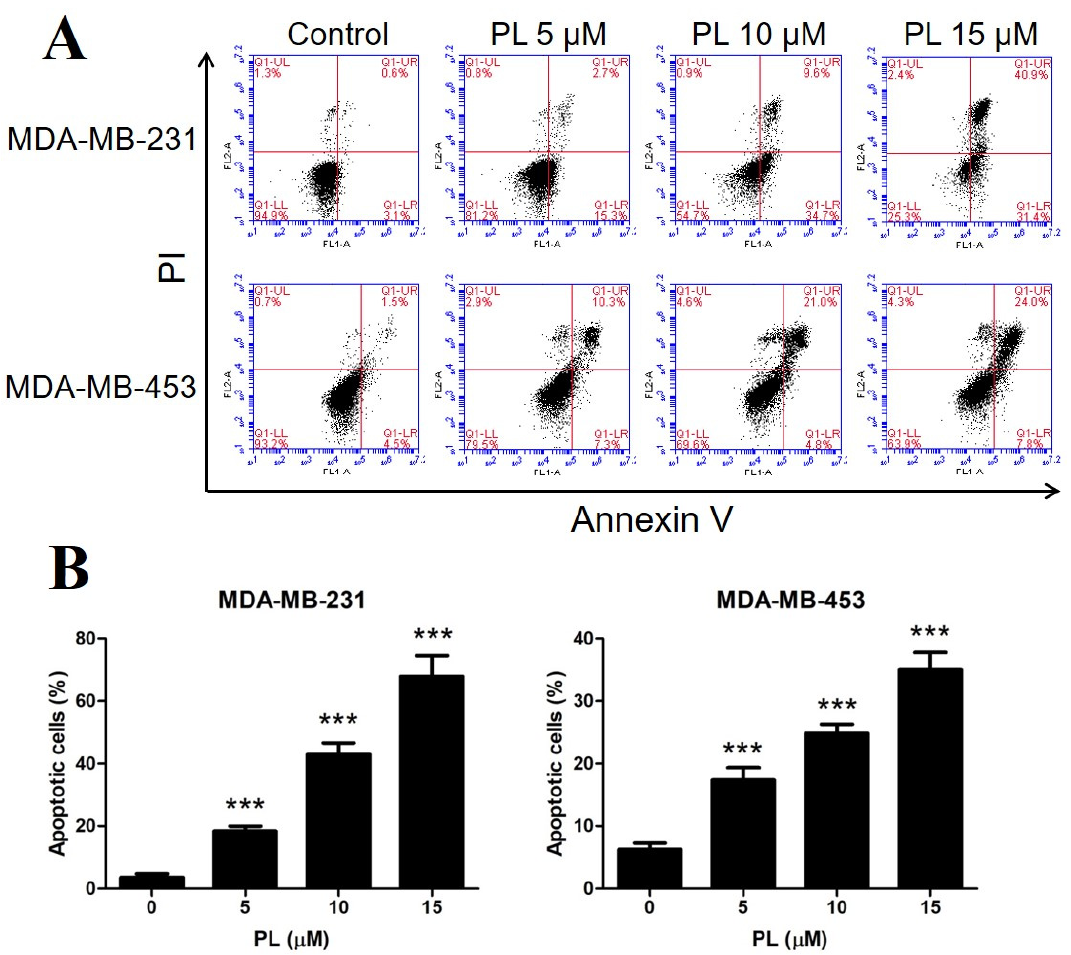
Figure 2. Piperlongumine induces apoptosis in TNBC cells. ( A ) MDA-MB-231 and MDA-MB-453 cells were treated with 5, 10, or 15 µM PL for 48 h and stained with Annexin V/PI. DMSO was used as a vehicle control. The apoptotic rate was then detected by flow cytometry. ( B ) Cells in the Annexin V-positive area were considered apoptotic. *** p < 0.001 compared to the control.